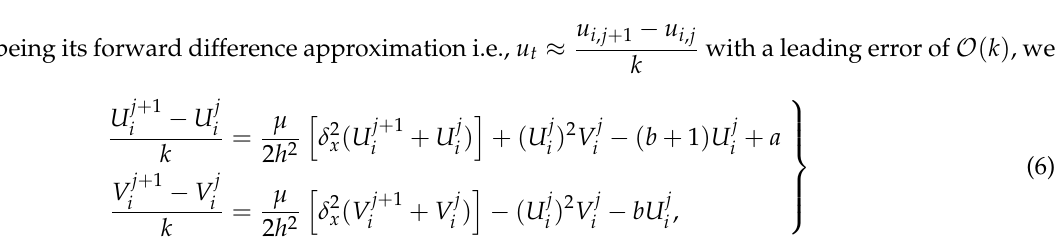
Figure 1. Stencil for Linearly Implicit Crank-Nicolson (LICN)